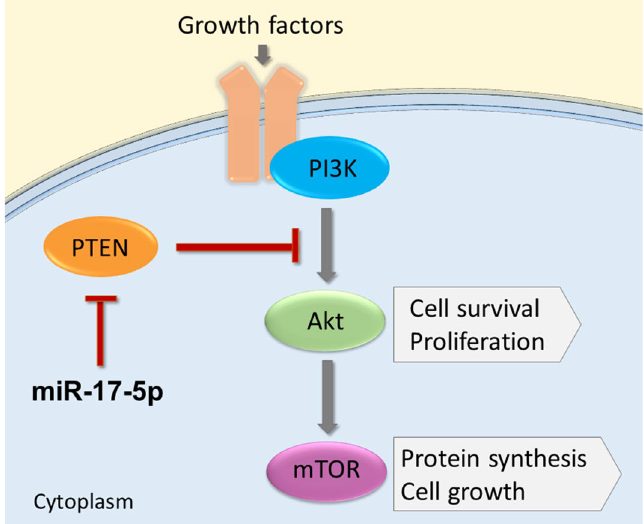
Figure 1. miR-17-5p inhibitorial mechanism on the PI3K/AKT/mTOR pathway in PCa. A simplified illustration of the PI3K/AKT/mTOR pathway, and miR-17-5p upregulation through inhibition of the tumor suppressor